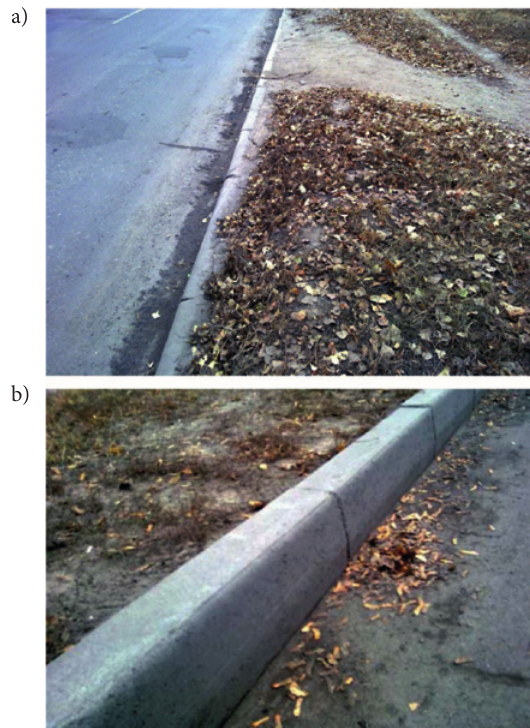
Fig. 1. Roadside of Akademika Pavlova street (a) and Traktorostroiteley avenue (b). Surface runoff can be excluded the given study, because all roads were confined by